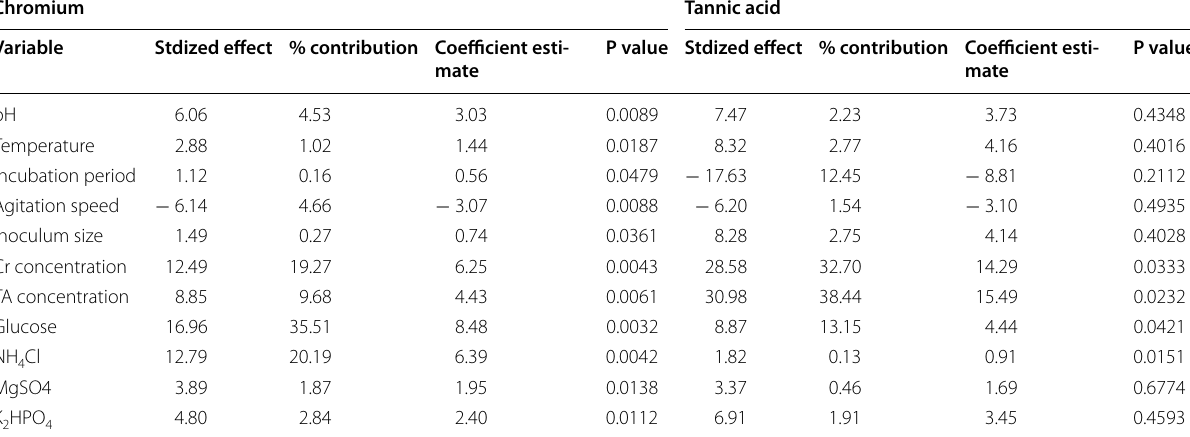
Table 2 Screening of critical factors for A. niveus Chromium Tannic acid Variable Stdized effect % contribution Coefficient esti-